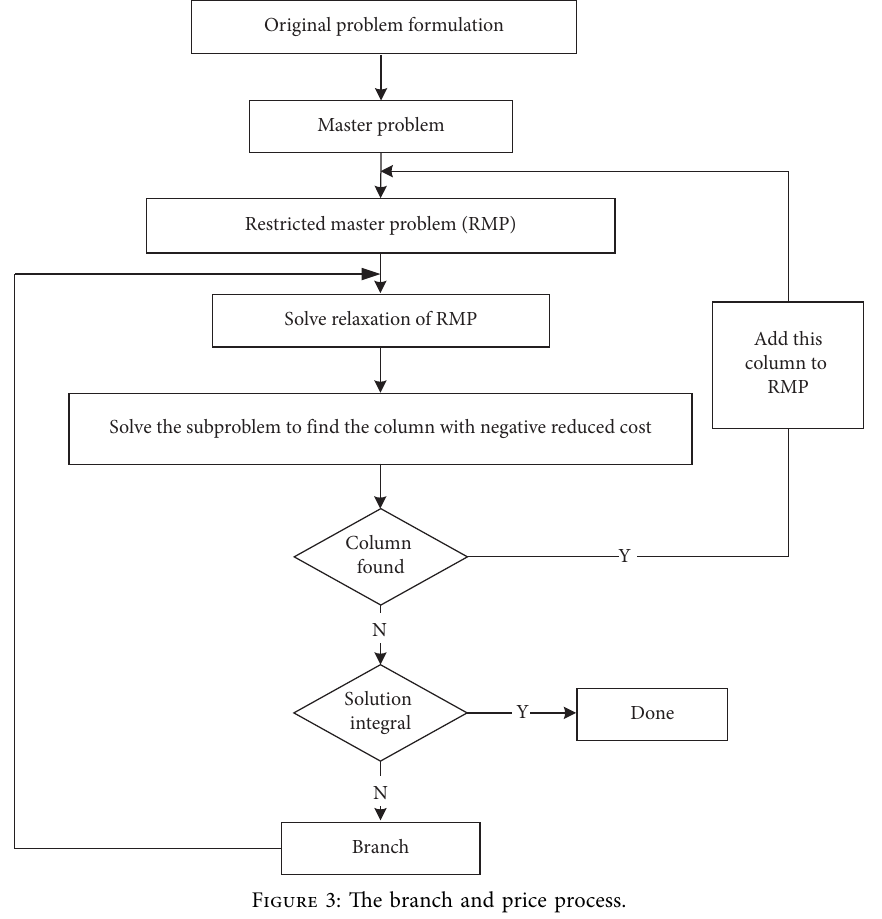
Figure 3: The branch and price process.